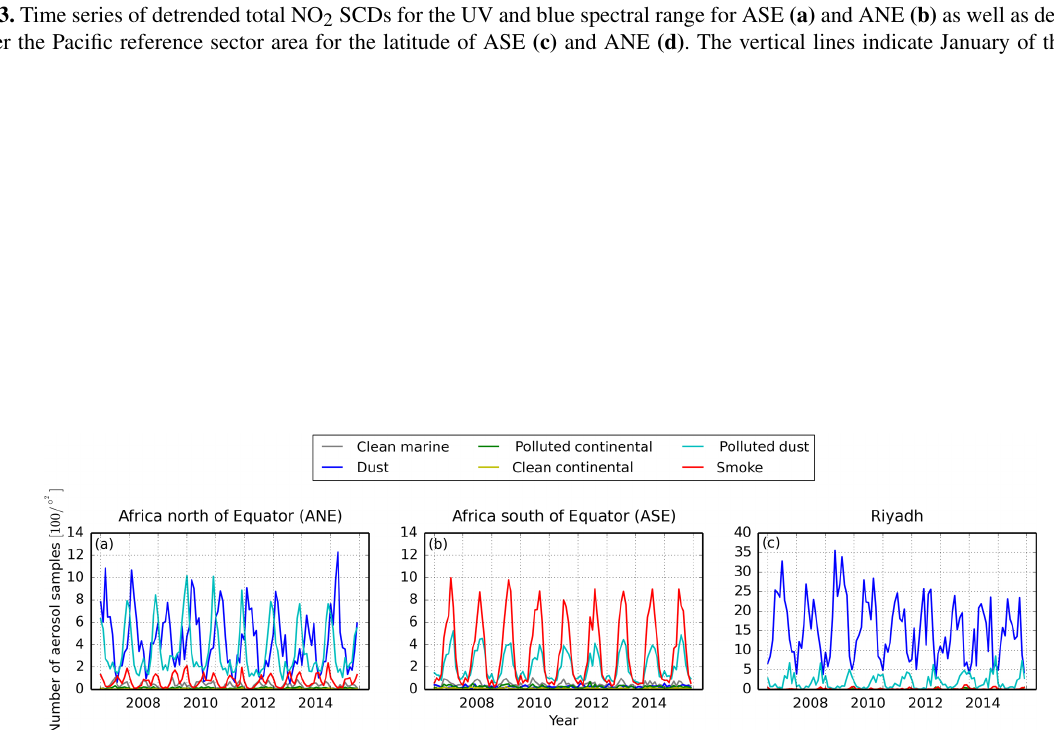
Figure A4. Time series for the number of samples of aerosol types for three different regions (CALIPSO data). To calculate the time series for the individual areas, the amount of aerosol in the grid box was weighted by the contribution of the grid box to the region. Note the different y axes. The vertical lines indicate January of the individual